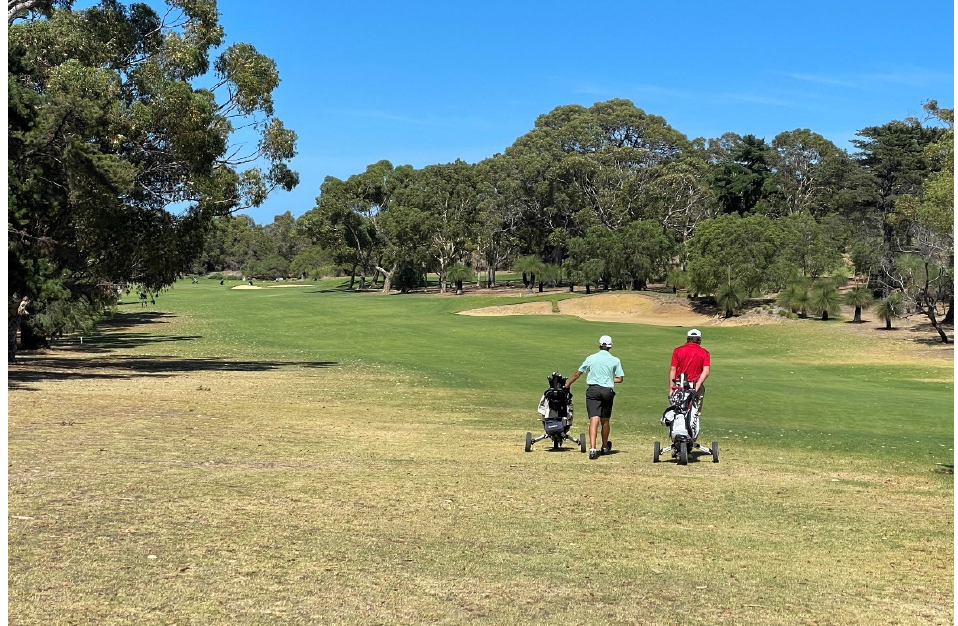
Figure 2. Typical scene in a golf course in the study region in summer. The irrigated fairway is bordered by corridors of vegetation containing tall trees ( Eucalyptus ), mid-story trees ( Acacia , Agonis ), small shrubs, and grasstrees ( Xanthorrhoea ) (photo by Paul Barber).